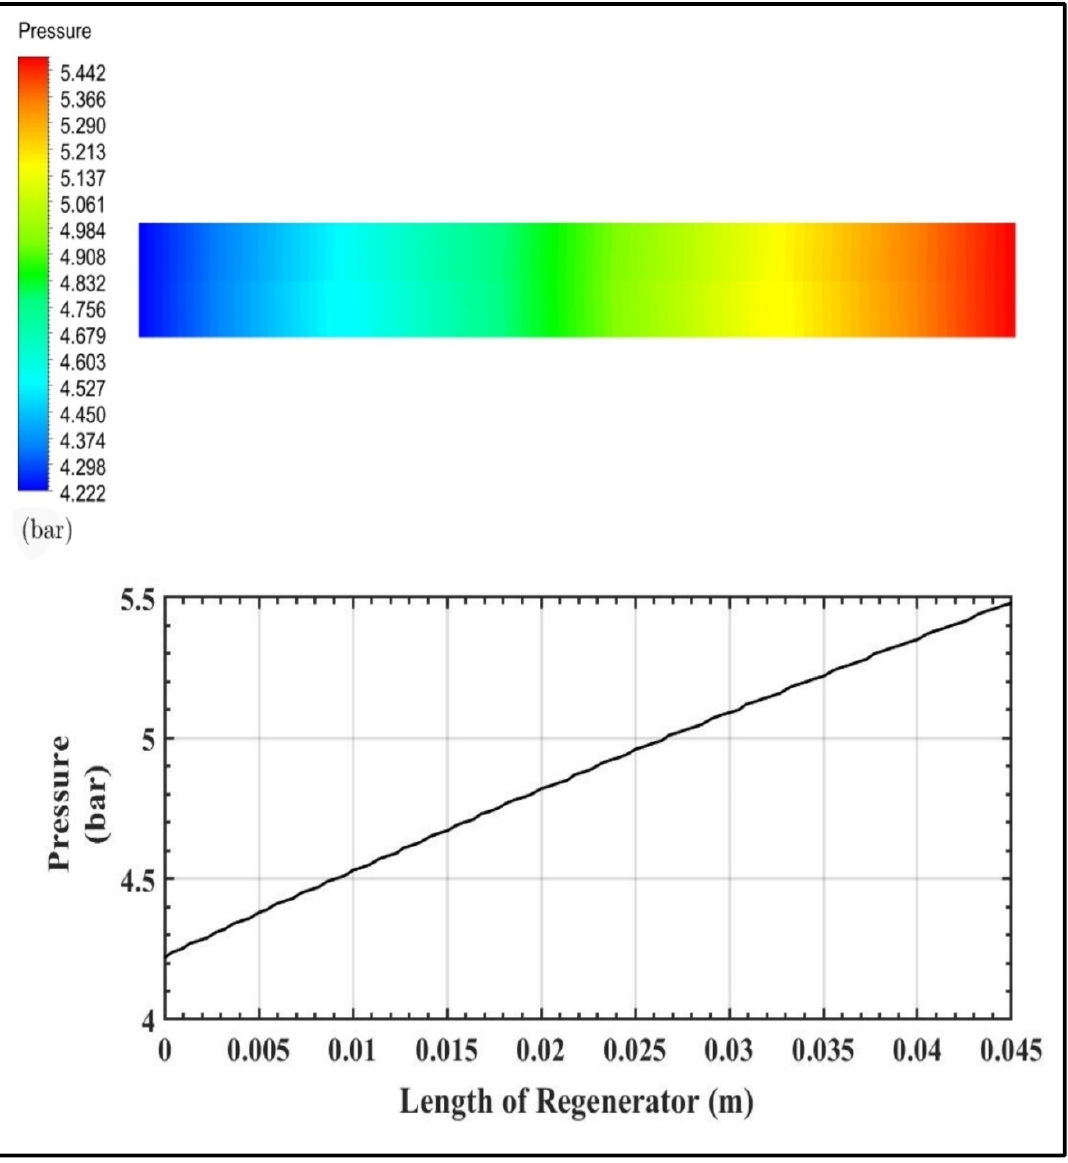
Figure 24. Variation of pressure along the length of the 200 mesh regenerator at 0.45 s.